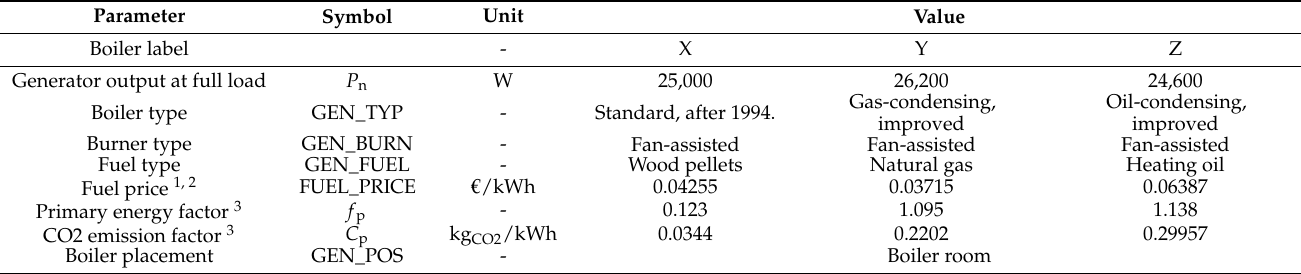
Table 6. Input data for calculation of